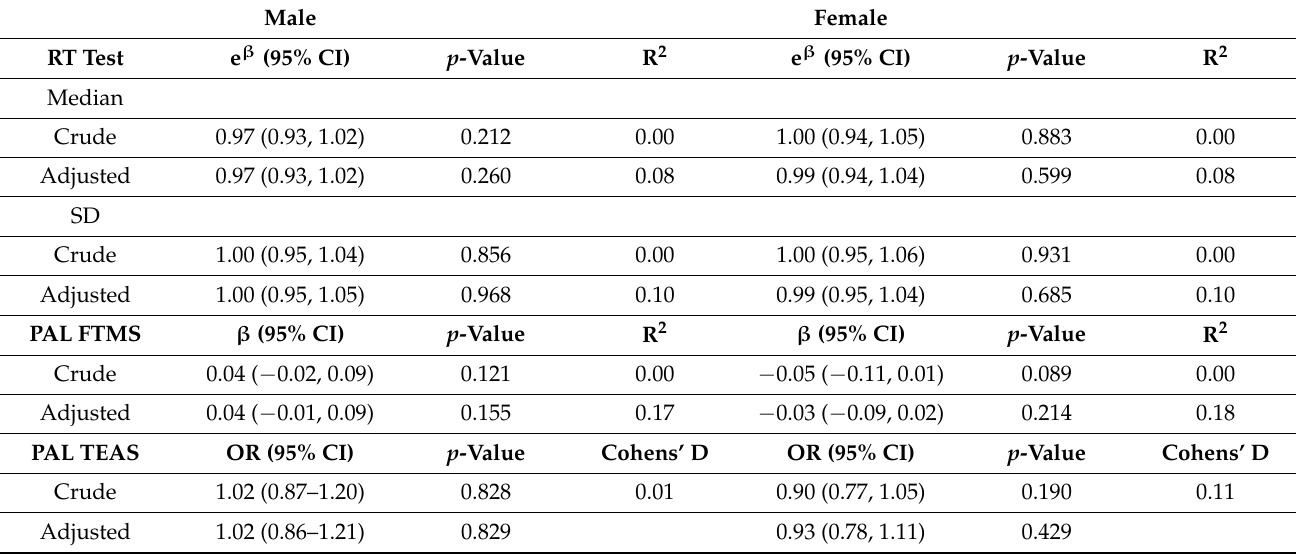
Table 4. Association of hazardous drinking PGS with RT test and PAL test in male and female schizophrenia patients.